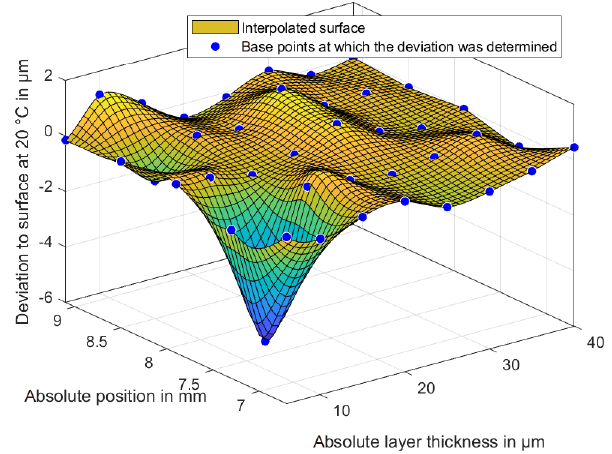
Figure 15. Standard deviation at 20 ◦ C and a test repetition of n = 20.